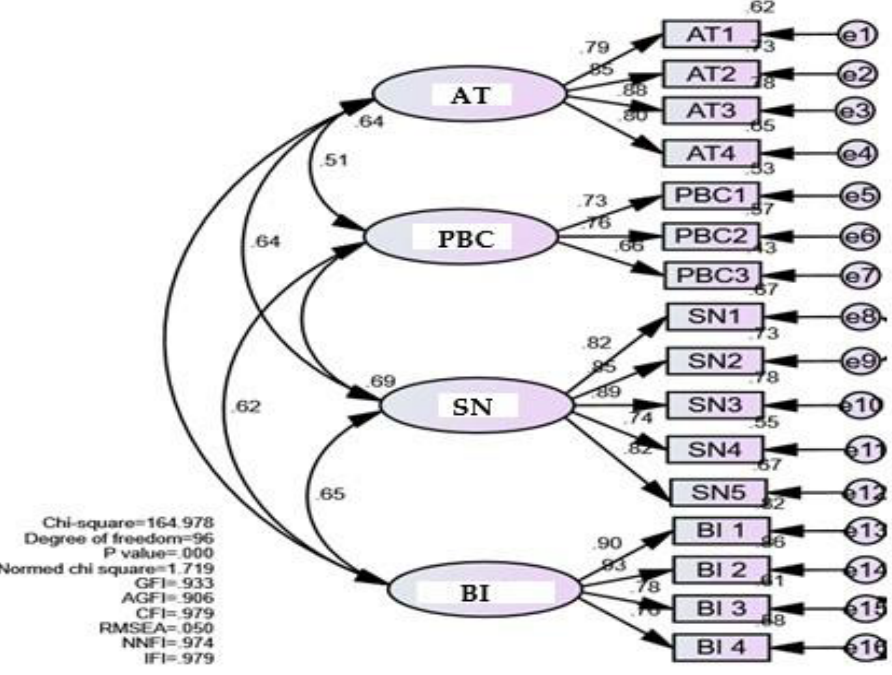
Figure 1. Confirmatory factor analysis; AT = attitude; SN = subjective norms; PBC = perceived behavioural control; BI = supplementation intention; GFI = goodness of fit index; AGFI = adjusted goodness of fit index; CFI = comparative fit index; NNFI = non-normed fit index; IFI = incremental fit index; RMSEA = root mean square error of approximation. Table 4. Effects of ANC on BI and perceived